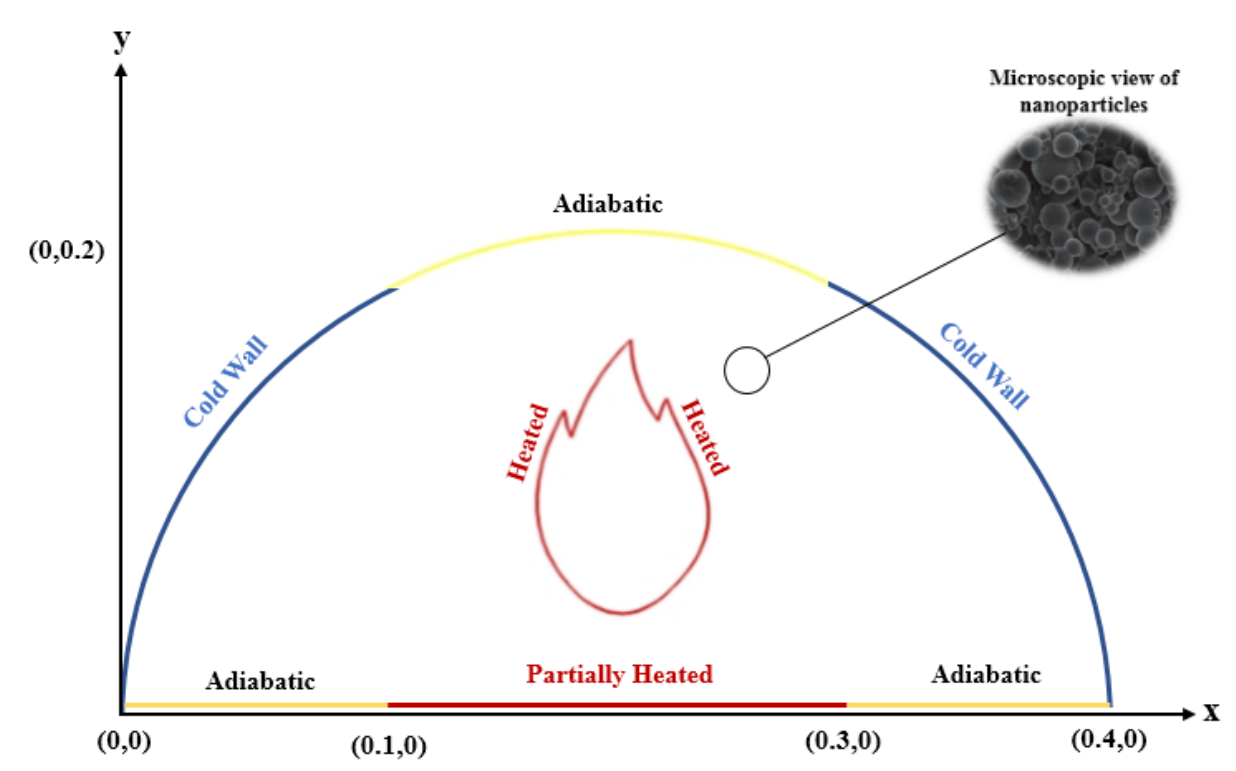
Figure 1. Schematic diagram of the present problem.